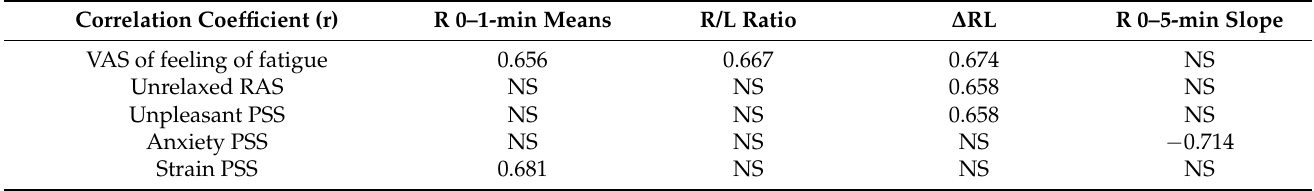
Table 1. Significant correlation between the subjective test and time-resolved spectroscopy data in the fatigue-inducing